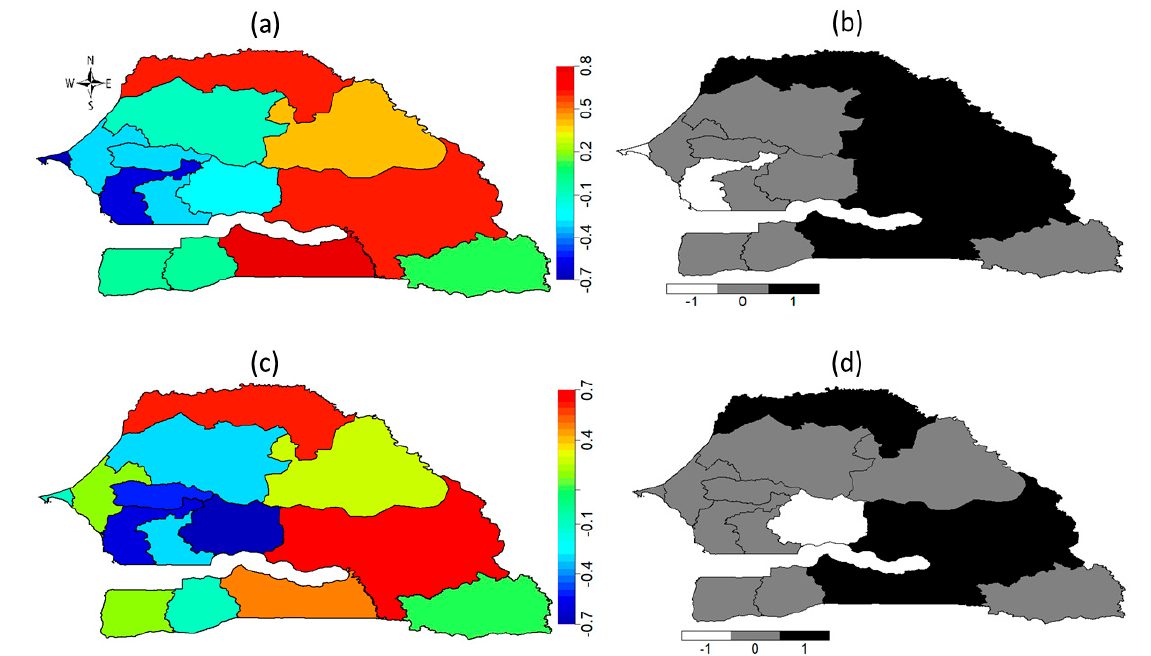
Figure 4. ( a ) Posterior risk map and ( b ) 95% posterior significance map based on Model 2; ( c ) Posterior risk map and ( d ) 95% posterior significance map based on Model 3. Deep blue to red corresponds to low risk to high risk. Black colour indicates significantly high-risk regions, white colour indicates significantly low risk regions and grey colour indicates non-significant regions. Evidence from 2017 SDHS.